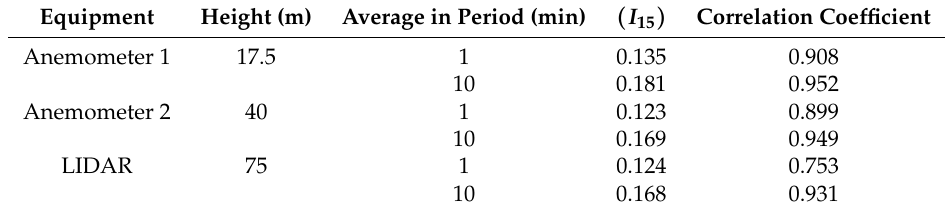
Figure 13. Estimation of characteristic turbulence intensity I 15 using extrapolation of a linear fit to measure the standard deviation versus mean wind speed data (longitudinal component) at heights of 17.5 and 40 m for a 10-min mean time. The linear fit is adjusted to the linear equation I 15 = ( K 0 /15 ) + k 1. ( a ) K 0 = 0.0, K 1 = 0.18, I 15 = 0.181 and r = 0.952 and ( b ) K 0 = 0.0, K 1 = 0.1693664, I 15 = 0.17 and r = 0.9487. Table 5. Calculated values of I 15 for different intervals of average wind speed (1 Hz sampling rate). Equipment Height (m) Average in Period